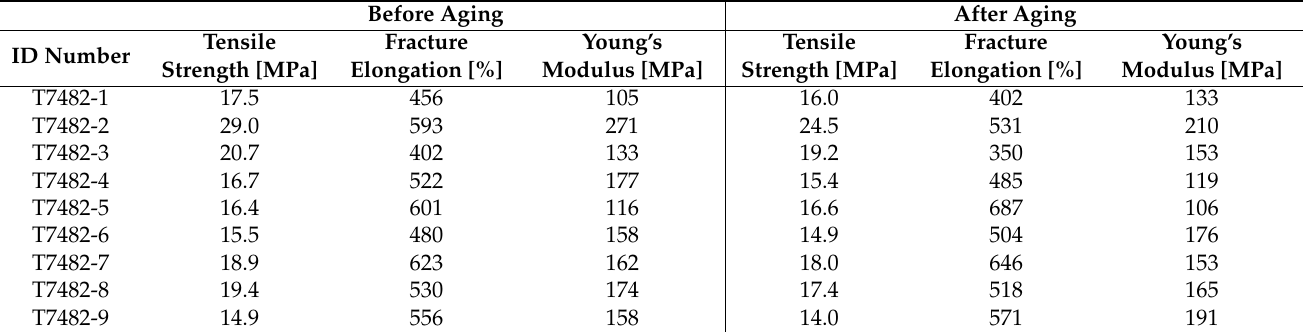
Table 4. Properties parallel to the direction of production.